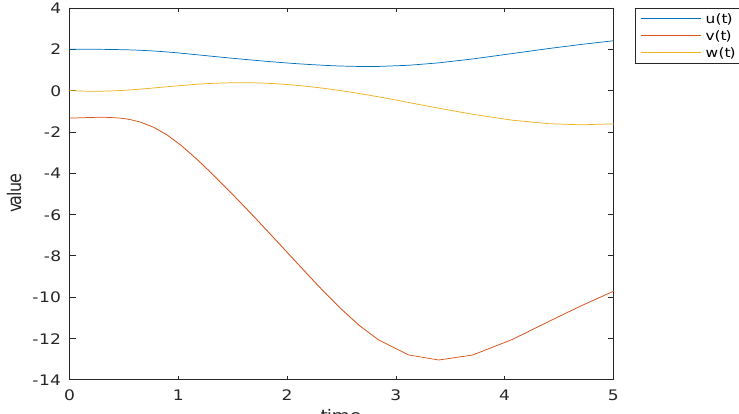
Figure 1. Simulation of solutions in Example 1.